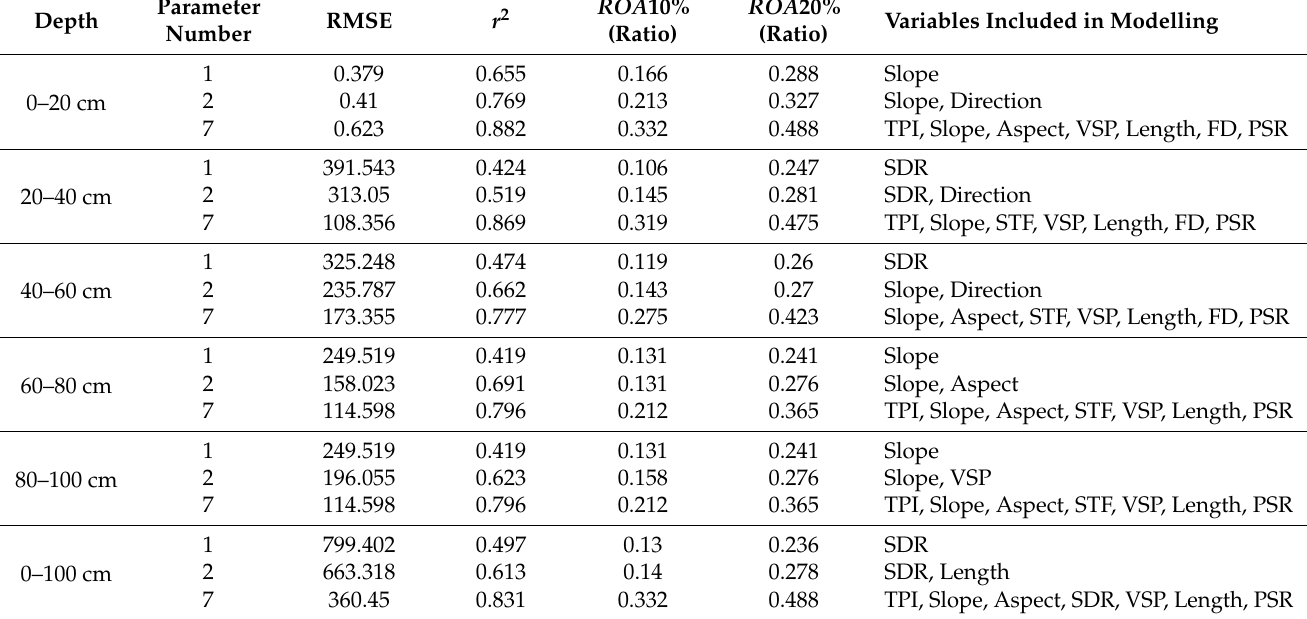
Table 2. Ten-fold ANN model